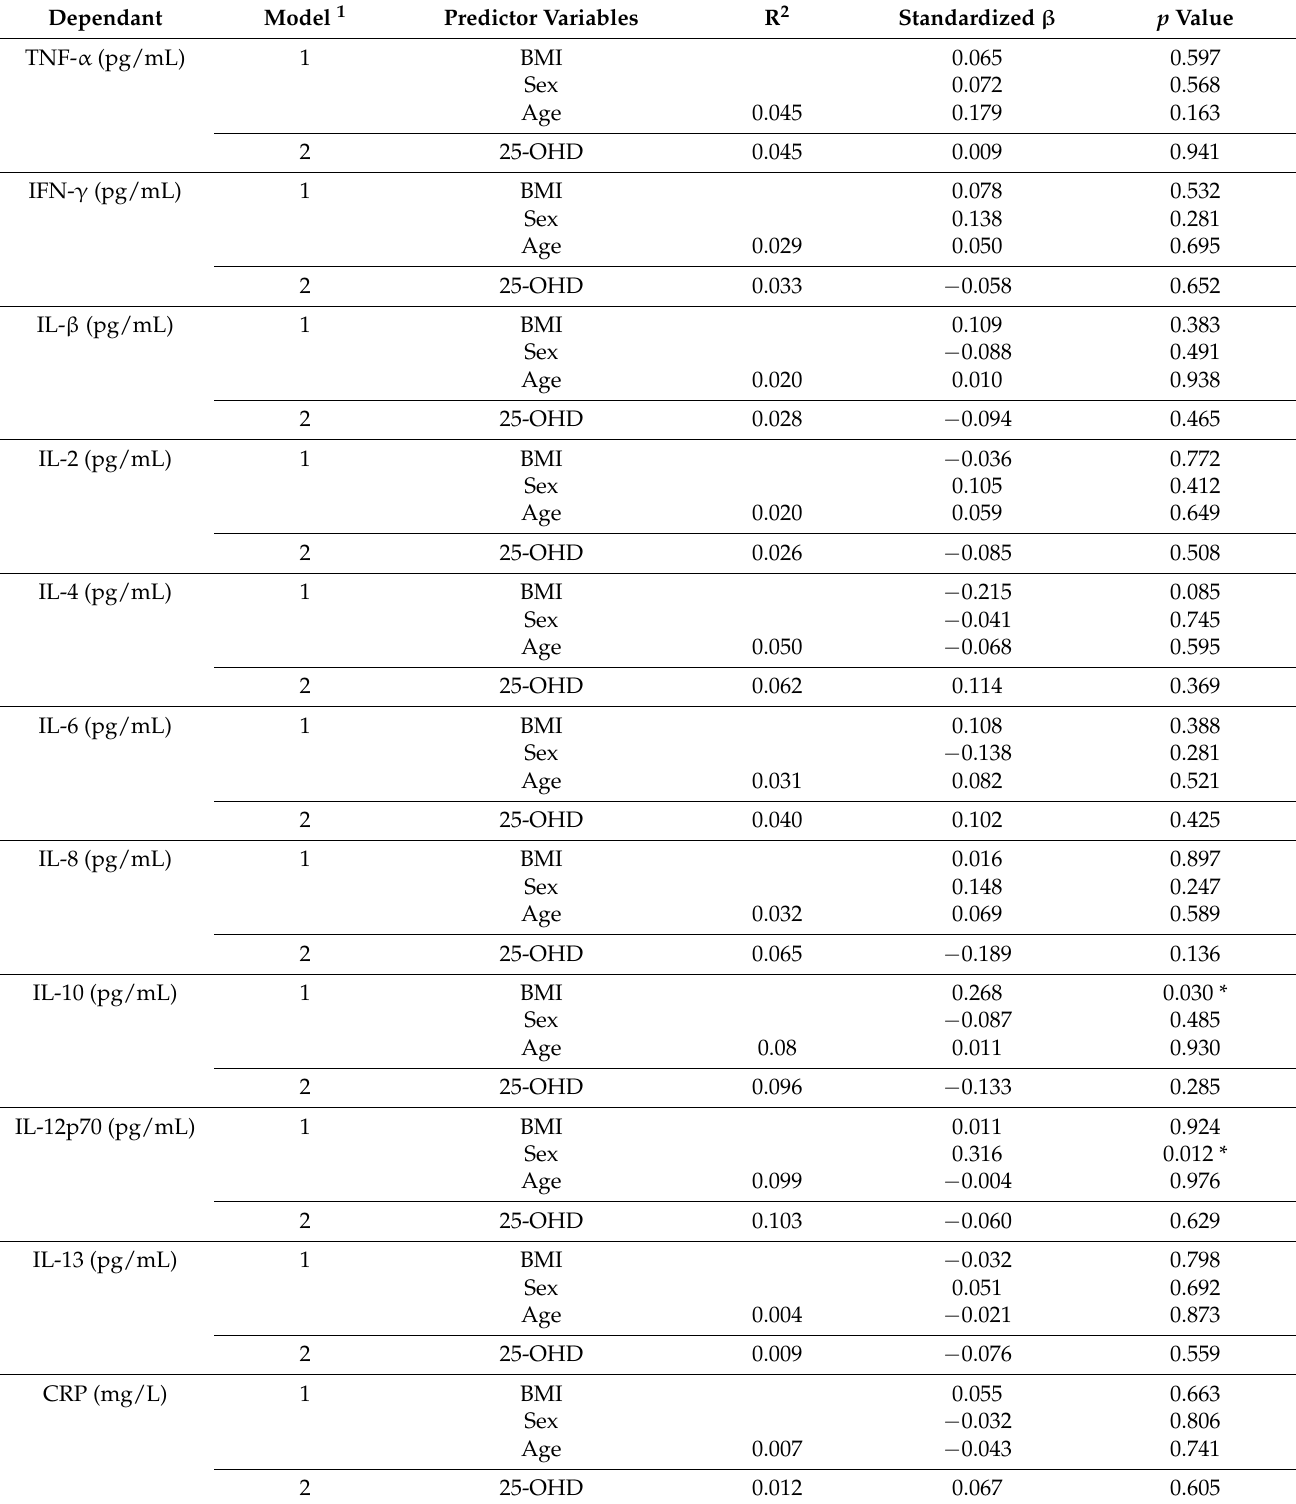
Table 4. Multiple regression showing associations between 25-OHD concentration and inflamma- tory